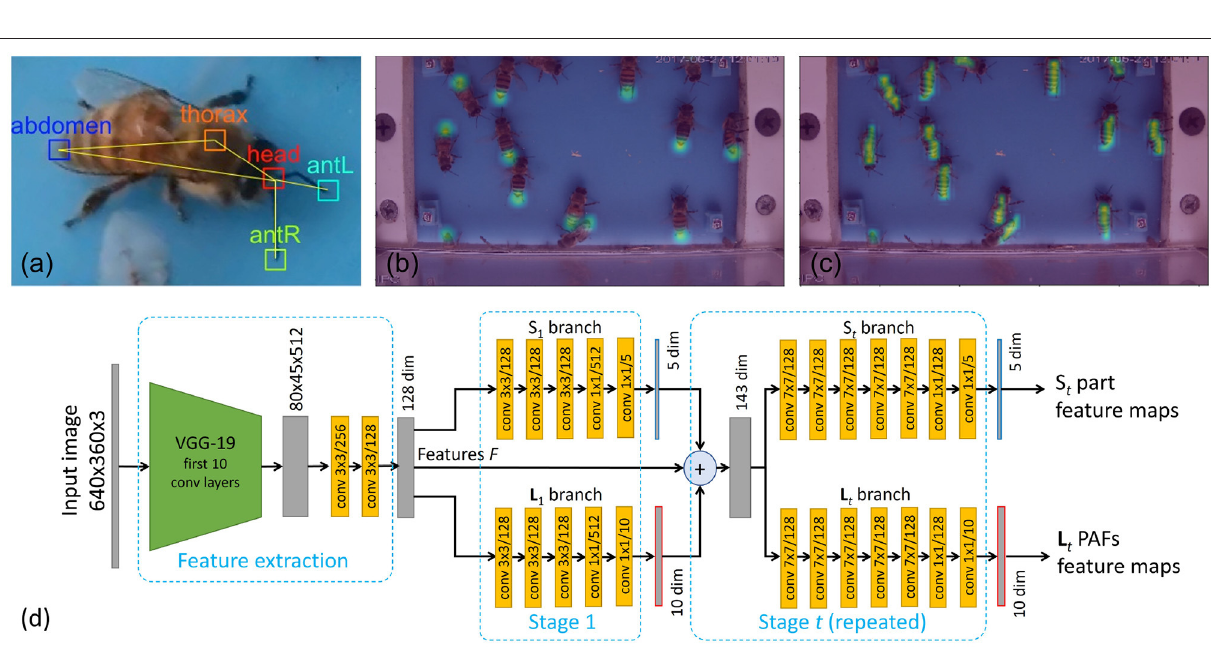
Frontiers in Computer Science |